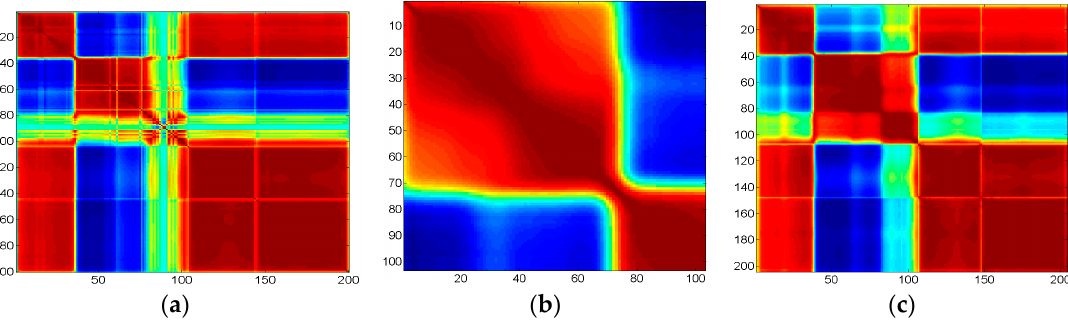
Figure 3. The maps of correlation coefficients of spectral bands in different datasets: ( a ) Indian Pines; ( b ) University of Pavia; and ( c ) Salinas.